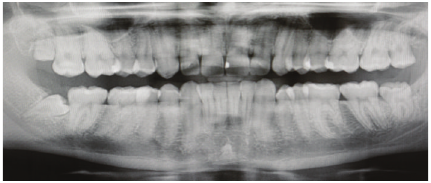
Figure 3: Postoperative orthopantograph (OPG) showing the extraction socket of the lower right third molar.